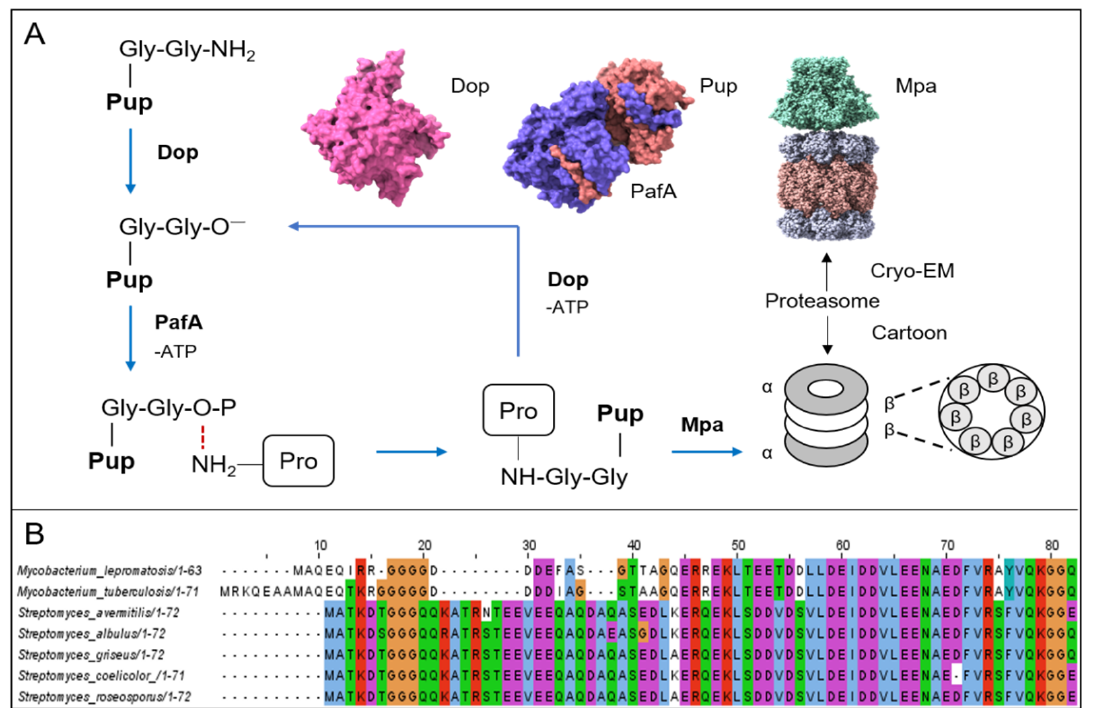
Figure 4. Overview of the degradation mechanism of Pup–proteasome and different types of Pup. ( A ) Degradation diagram of the interaction between the proteasome, Pup, Dop, PafA, and Mpa. The pink Cryo—EM structure of Dop is identified from Acidothermus cellulolyticus . The Cryo—EM structure of Pup-PafA complex is identified from Corynebacterium glutamicum . The purple area represents PafA, and the orange area represents Pup. The Cryo—EM structure of the Mpa—proteasome complex is identified from Mycobacterium tuberculosis (the Cryo—EM structures were all downloaded from the PDB database). ( B ) The alignment of Pup amino acid sequences between M. lepromatosis ,